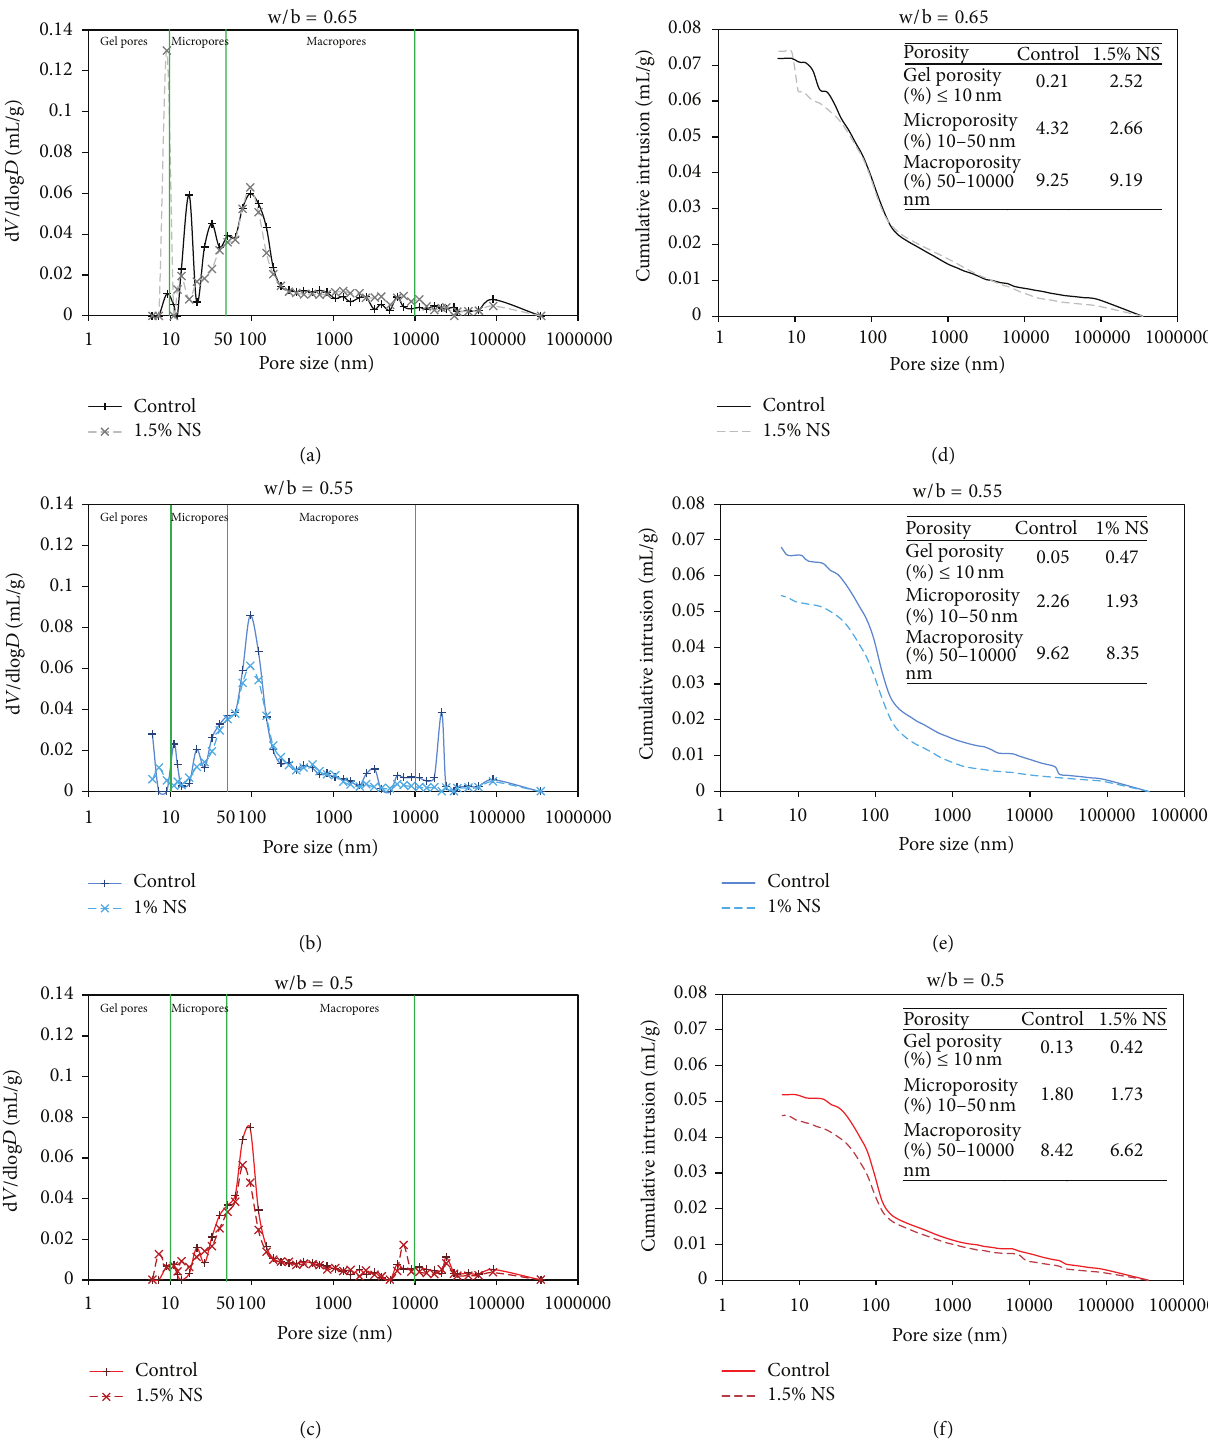
Figure 11: Pore size distribution and cumulative intrusion volume of selected specimens of